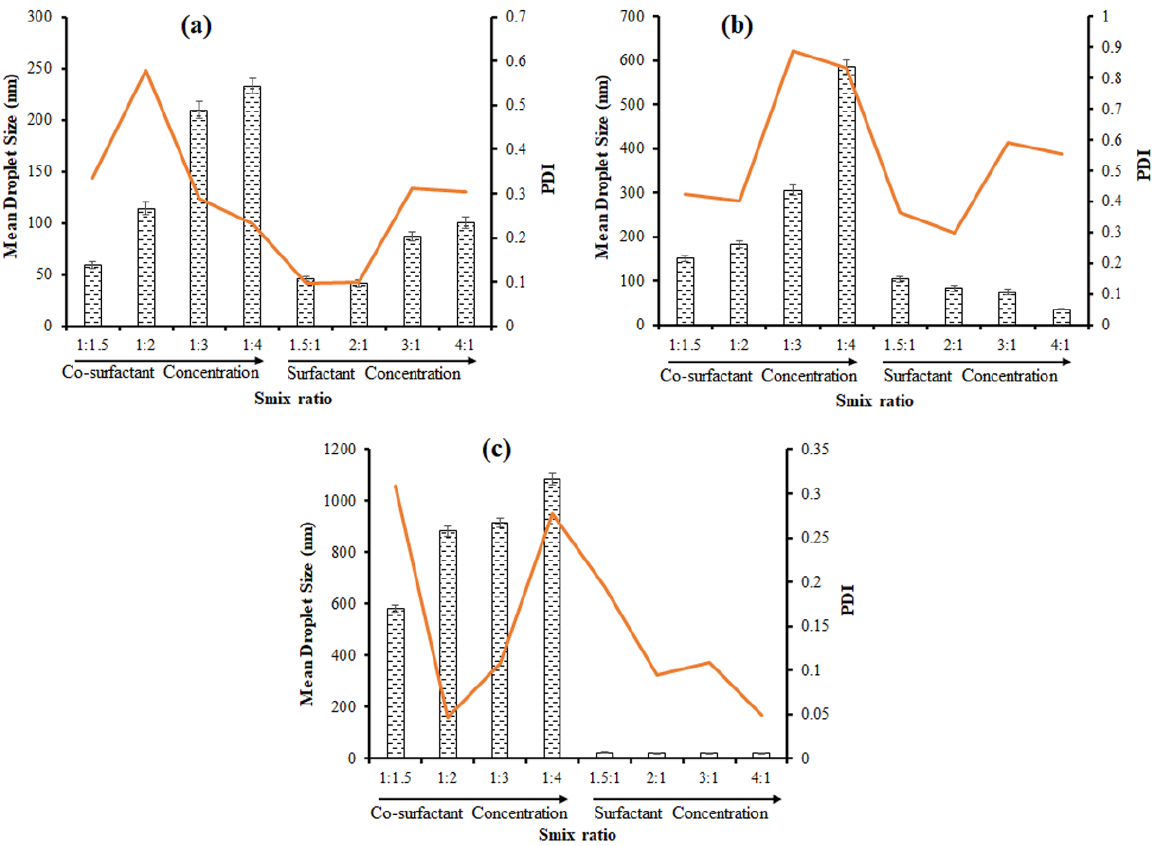
Figure 5. Impact of Km ratio on mean droplet size and PDI of NE system composed of ( a ) OA as oil phase; ( b ) C90 as oil phase; ( c ) EO as oil phase.